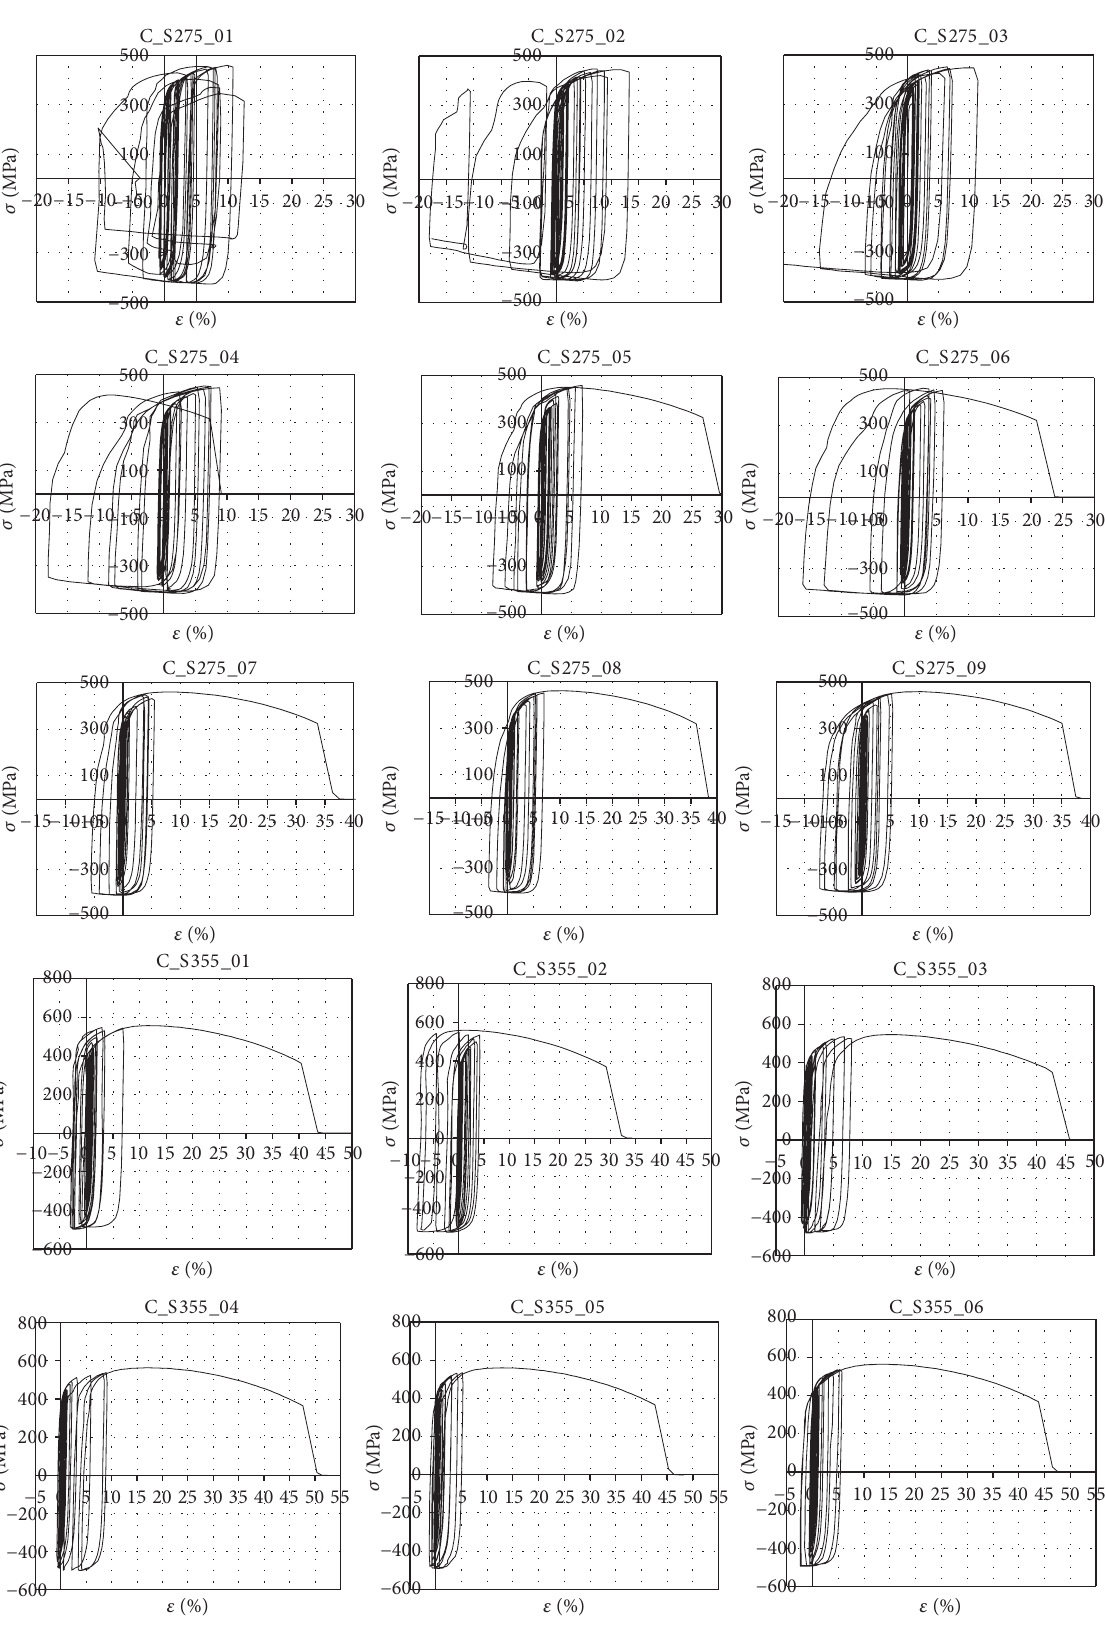
Figure 6: The hysteresis stress-strain curves for steel grades S275 and